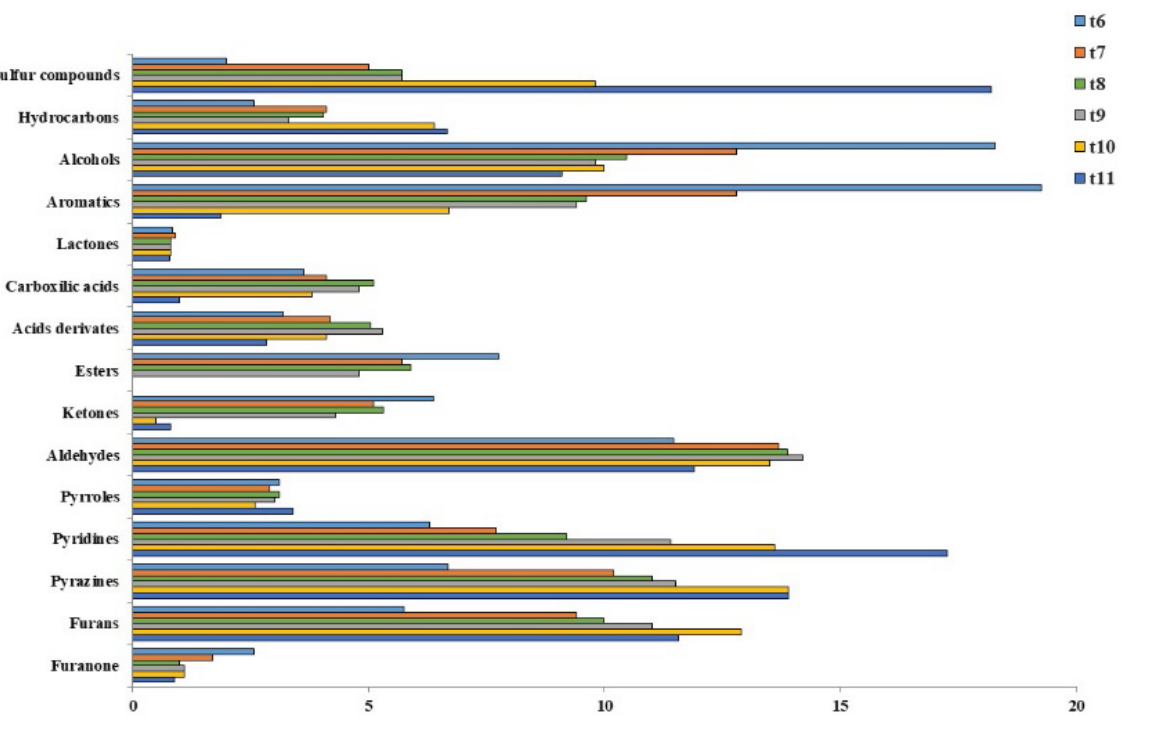
Figure 6. Chemical distribution of the VOCs identified in the roasted coffee beans submitted to different thermal treatments (t6–t11).